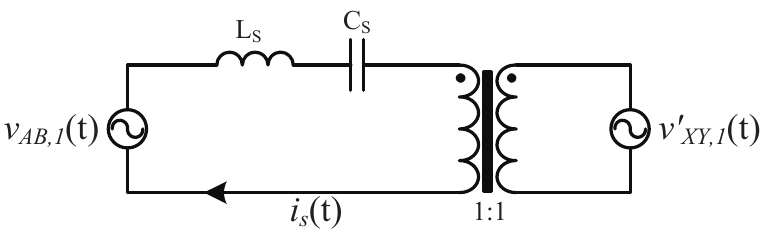
Figure 4. Equivalent circuit for steady-state analysis using fundamental harmonics approximation